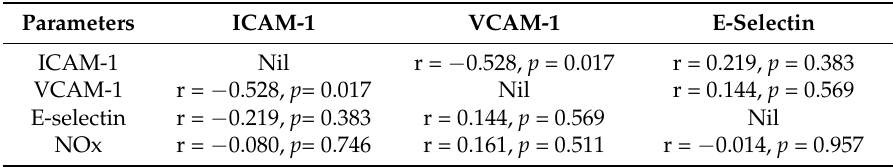
Table 4. Correlation between levels of NOx and levels of soluble adhesion molecules in HbSC patients. Parameters ICAM-1